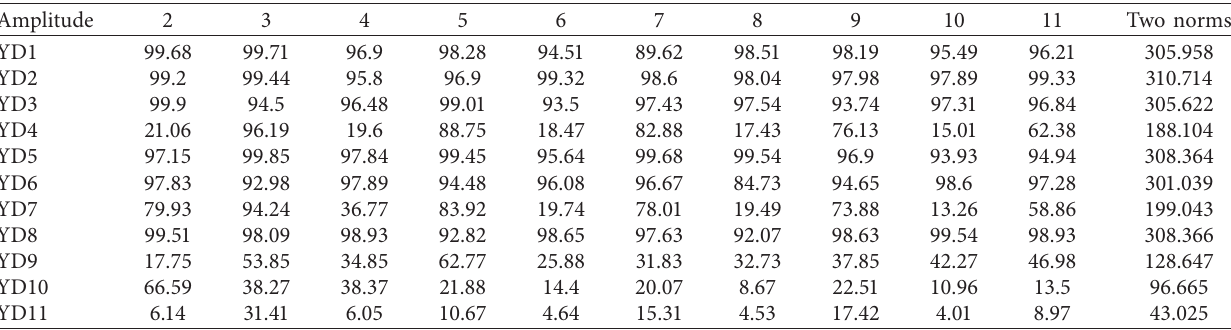
Figure 7: Comparison diagrams of active power and reactive power (left and right are device YD1 and device YD9, respectively). Table 4: Device amplitude of kth harmonic content rate.